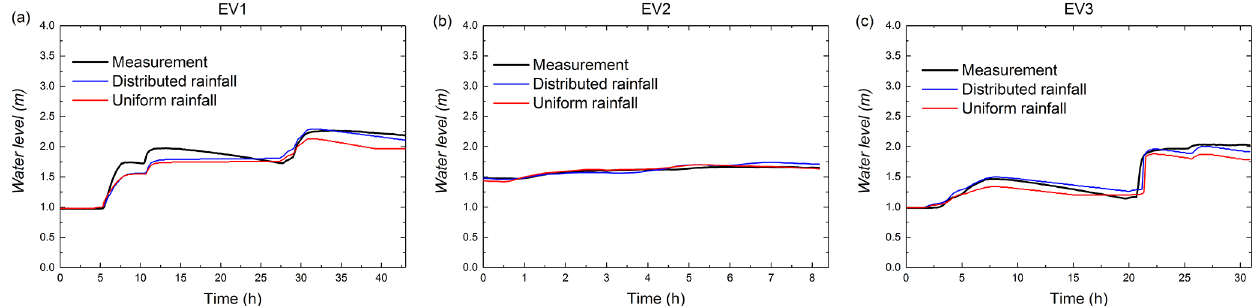
Figure 10. Comparison of the observed and simulated water levels (simulated with distributed rainfall and uniform rainfall) of the three rainfall events, namely (a) EV1, (b) EV2, and (c) EV3.